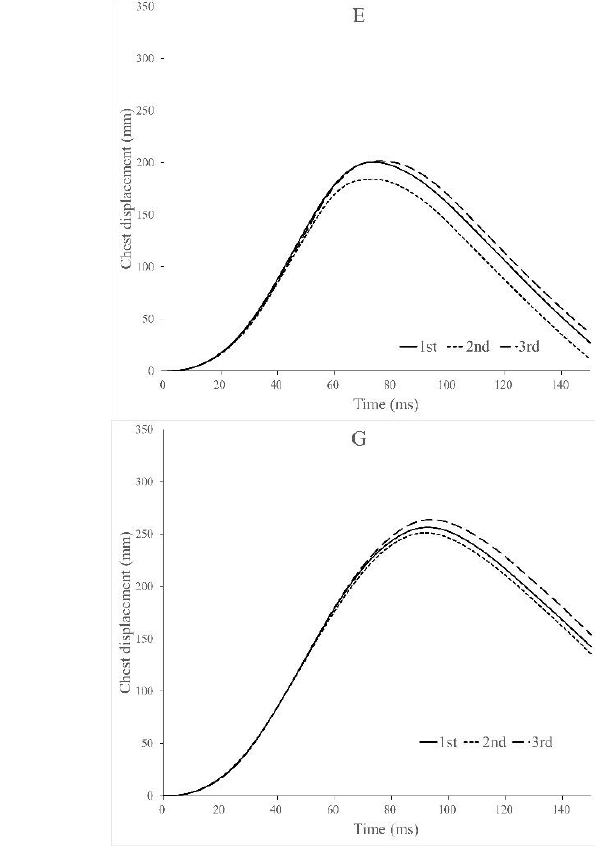
Figure 7. Time courses of the chest displacement, using a correctly fitted seatbelt, optionally equipped with a pretensioner and/or force limiter.